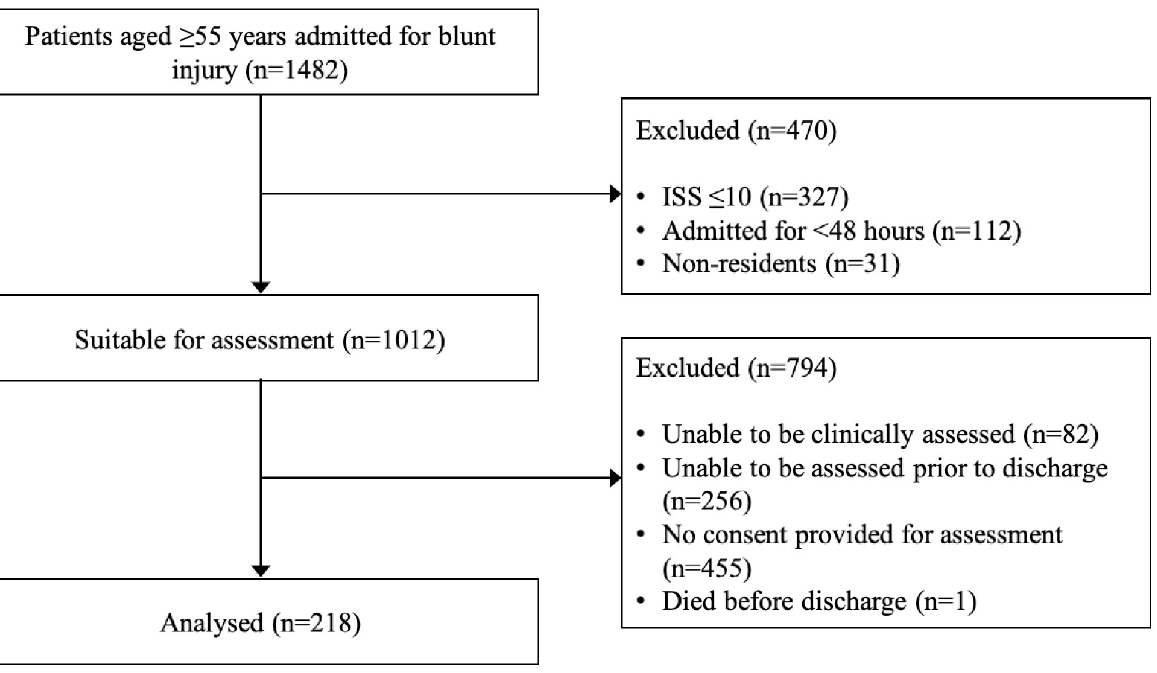
Fig 1. Participant recruitment